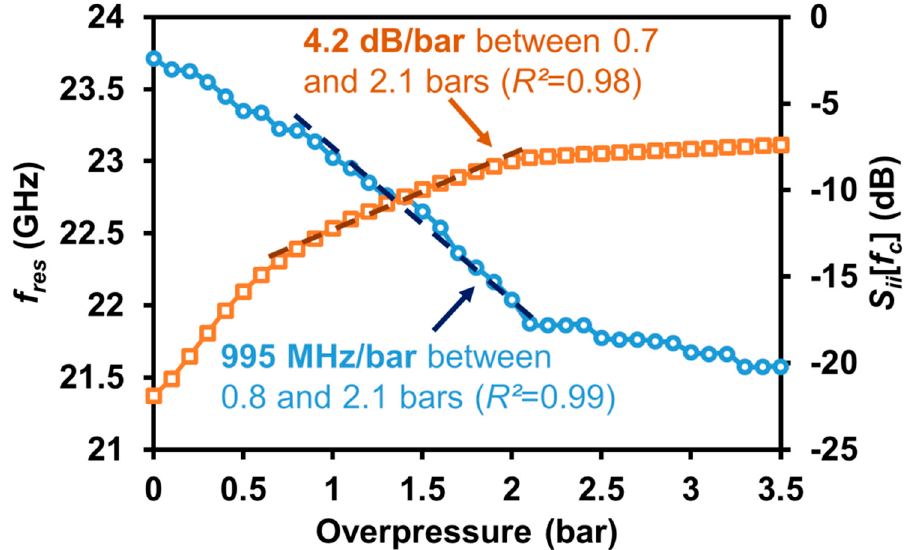
Figure 4. Variation of the measured resonant frequency f res and the input reflection coefficient S 11 at the operating frequency f c (=23.8 GHz) as a function of the applied pressure. R 2 denotes here the coefficient of determination of the linear regressions.